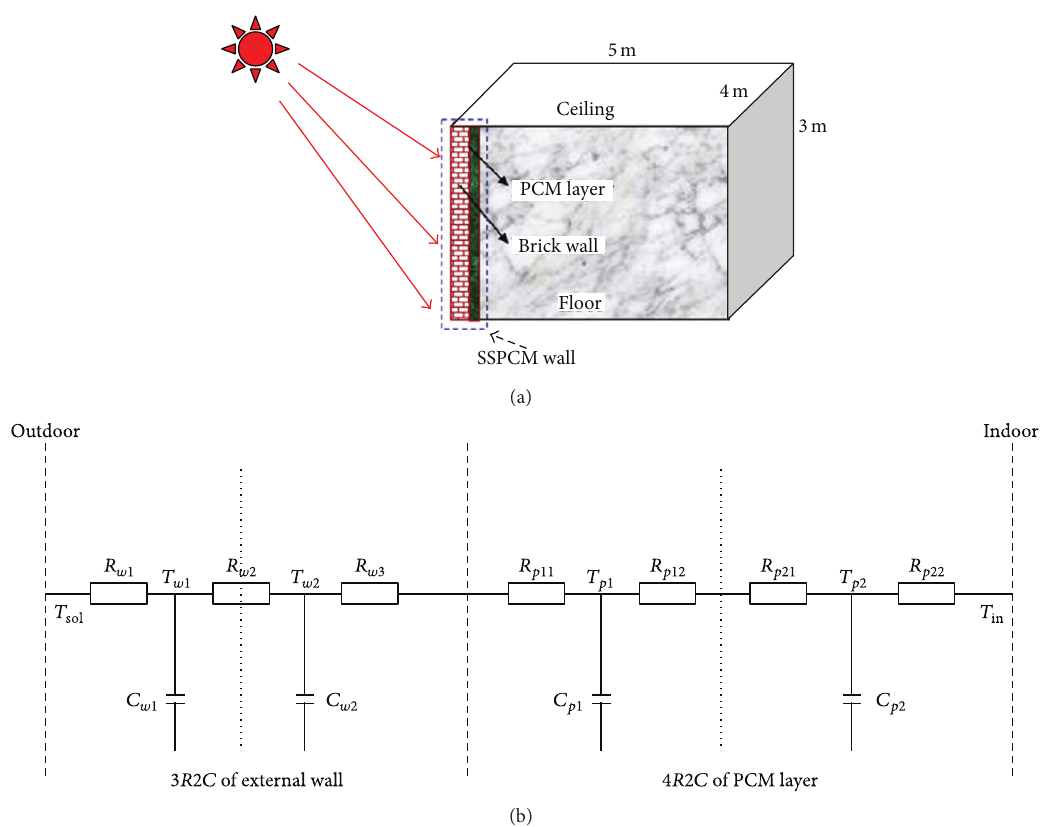
Figure 6: (a) Schematic of SSPCM wall and the ideal model house (b) Schematic of the simplified dynamic building model.